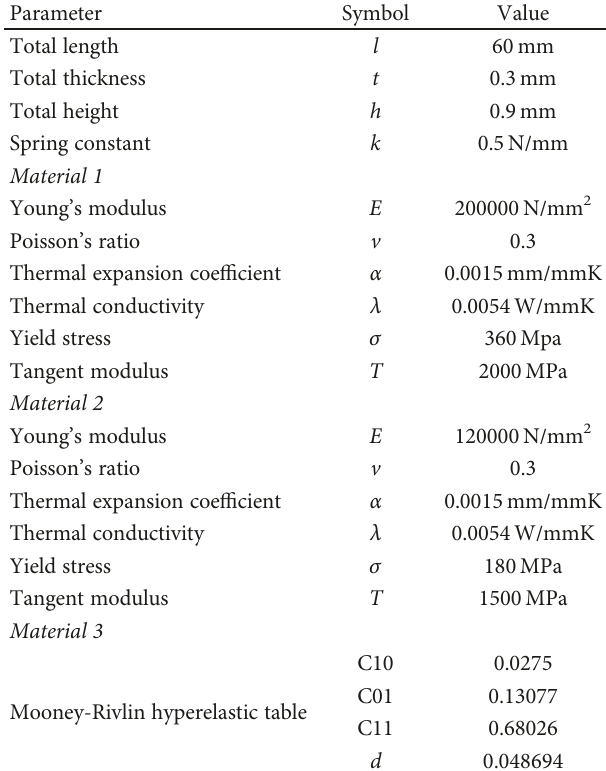
Table 2: List of parameters of the entire tendril body